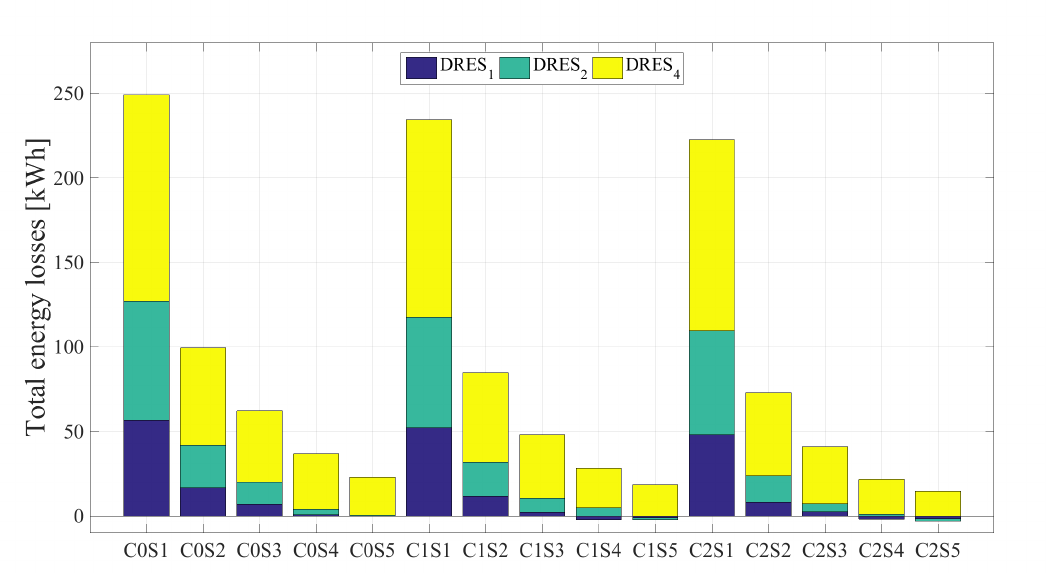
Figure 11. Total losses of renewable energy due to drooping of active power of all DRES when different test cases are